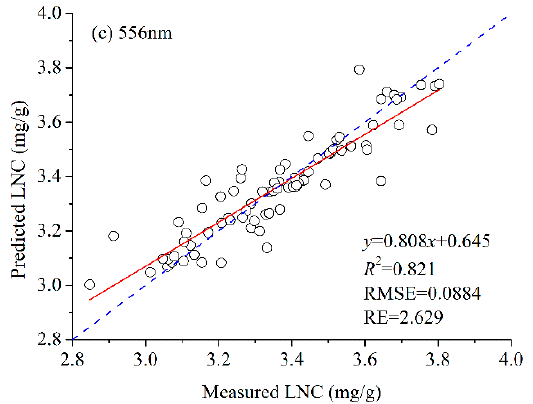
Figure 4. Relationship between the measured and predicted LNC by using BPNN based on fluorescence spectra with different excitation light wavelengths. ( a ) 355 nm, ( b ) 460 nm, ( c ) 556 nm. The blue dotted line is the 1:1 line. The red solid line is the linear regression.